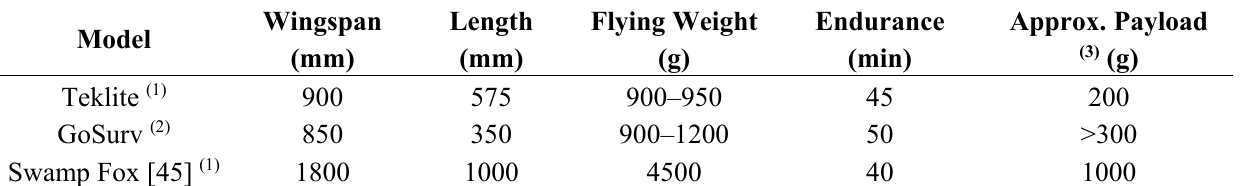
Table 2. Characteristics of UAVs identified as feasible platforms for this investigation. Model